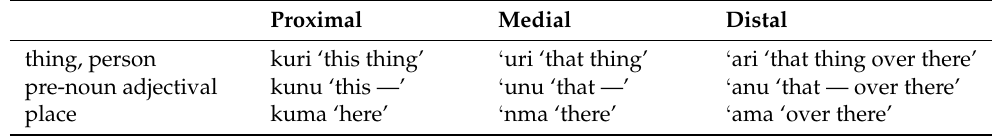
Table 7. Distance oriented deictic system of Uchinaaguchi.